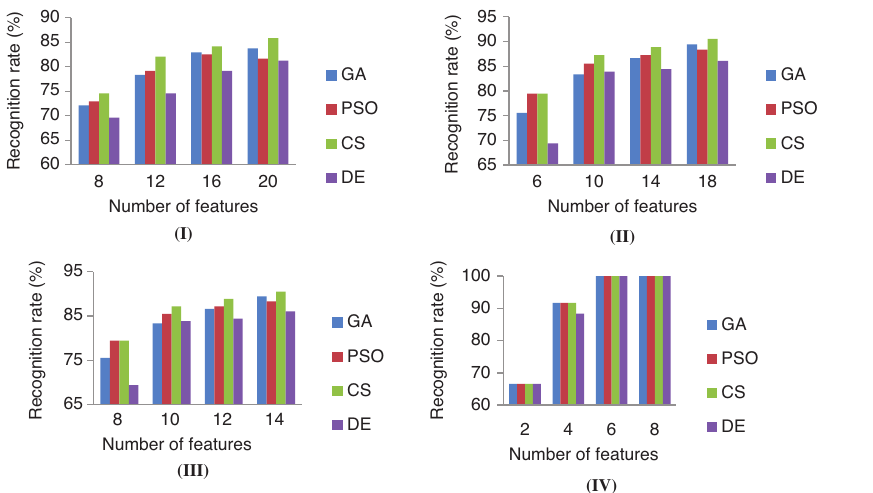
Figure 4: Recognition Rate for Different Numbers of Features for ORL Case 2: (I) 40 Classes, (II) 30 Classes, (III) 20 Classes, and (IV) 10